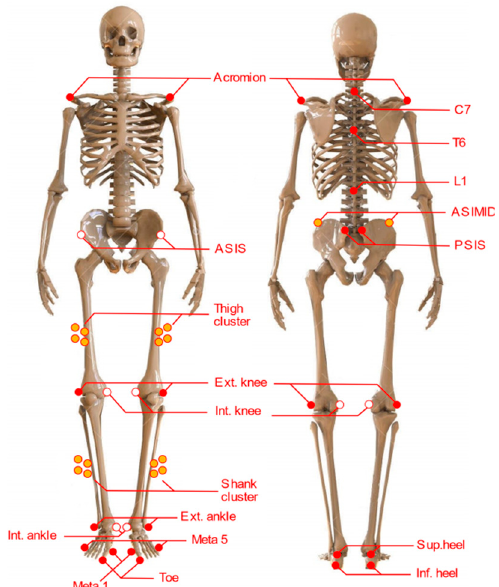
Figure 1. Anterior and posterior view of the location of the markers of the model used to capture the movement of the body. Filled with orange technical markers. Filled with white calibration markers.